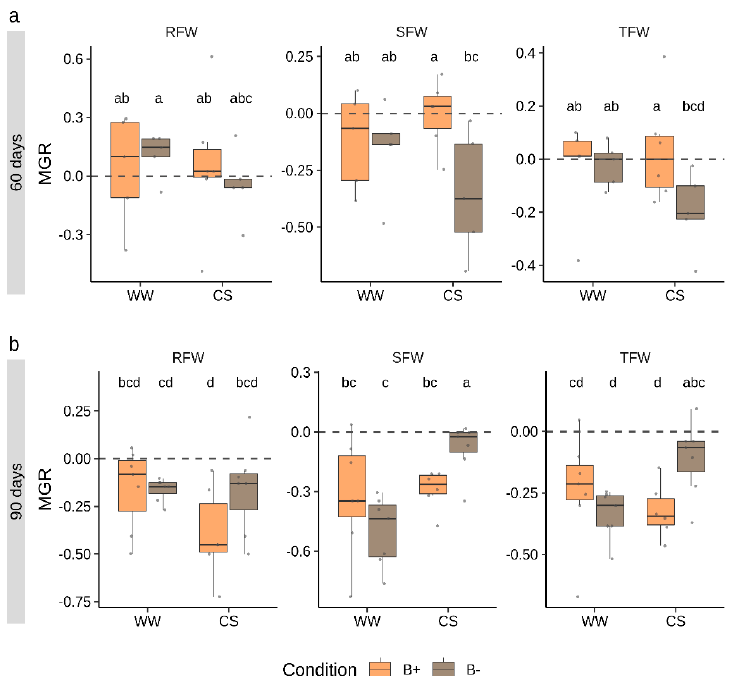
Figure 3. Mycorrhizal growth response (MGR) calculated on biomass parameters in tomato plants colonized by B + ad B − G. margarita lines at 60 days ( a ) and 90 days ( b ) after inoculation under combined stress (CS) and well-watered (WW) conditions. RFW, SFW and TFW refer to MGR values calculated on root, shoot and total fresh weight, respectively. Di ff erent letters indicate statistically supported di ff erences, also considering the two time points, according to Kruskal–Wallis test ( p < 0.05). Boxplots display median value (horizontal line), quartiles (boxes) and 1.5 × interquartile ranges (whiskers). Plants 2020 , 9 , x FOR PEER REVIEW